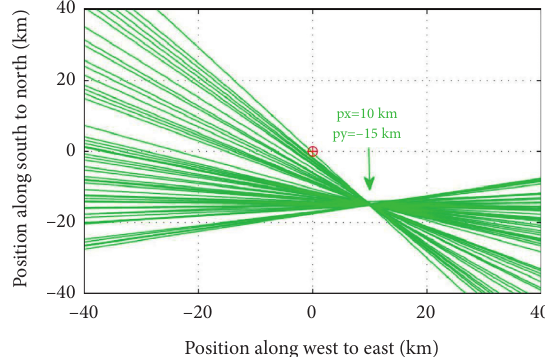
Figure 10: Initial position equation